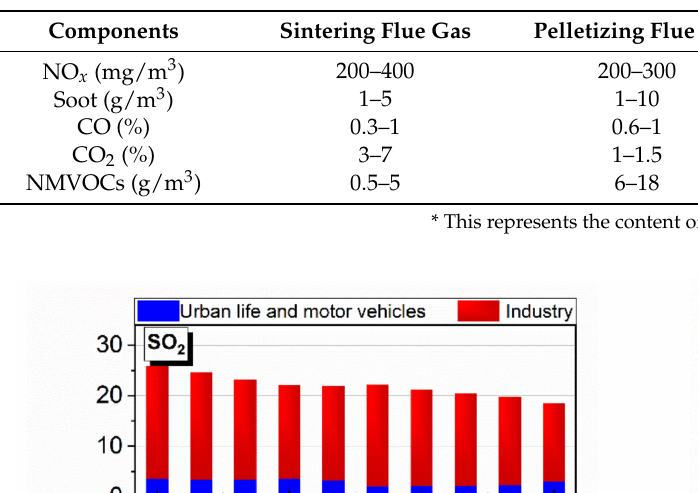
Table 1. The content of various pollutants in various gases.